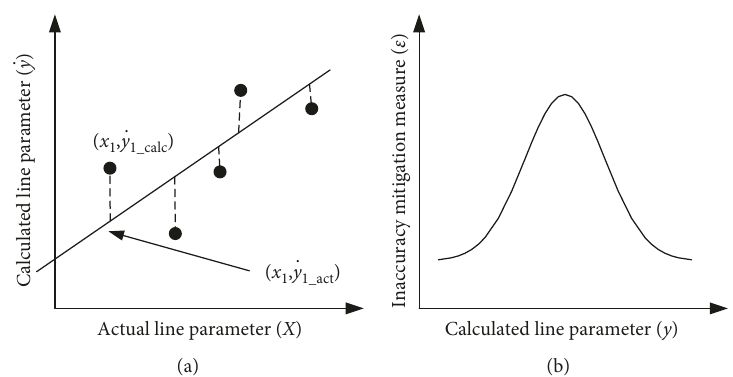
Figure 10: Indicative graphs of the proposed inaccuracy mitigation measure concept. (a) Actual vs. calculated line parameters. (b) Proposed inaccuracy mitigation measure.